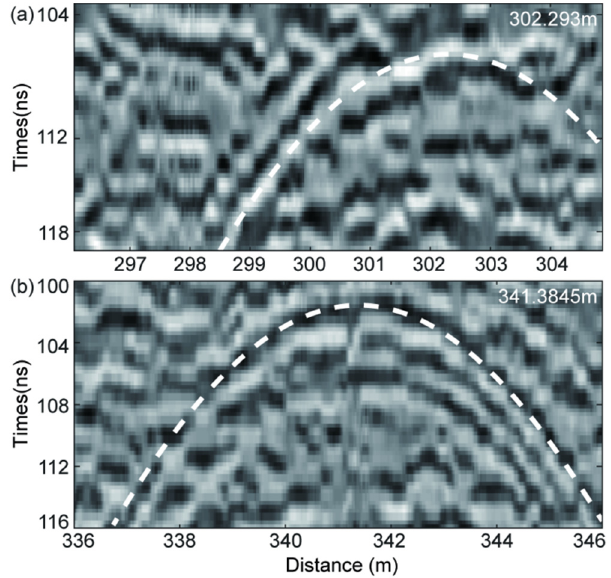
Figure 8. The comparison between the diffraction hyperbola and the CH-2B data within the local region. ( a ) The white dotted lines represent the diffraction hyperbola at 302.2930 m and 106.5625 ns for the stacking velocity of 0.142 m/ns; ( b ) the white dotted lines represent the diffraction hyperbola at 341.3845 m and 101.5625 ns for the stacking velocity of 0.165 m/ns.